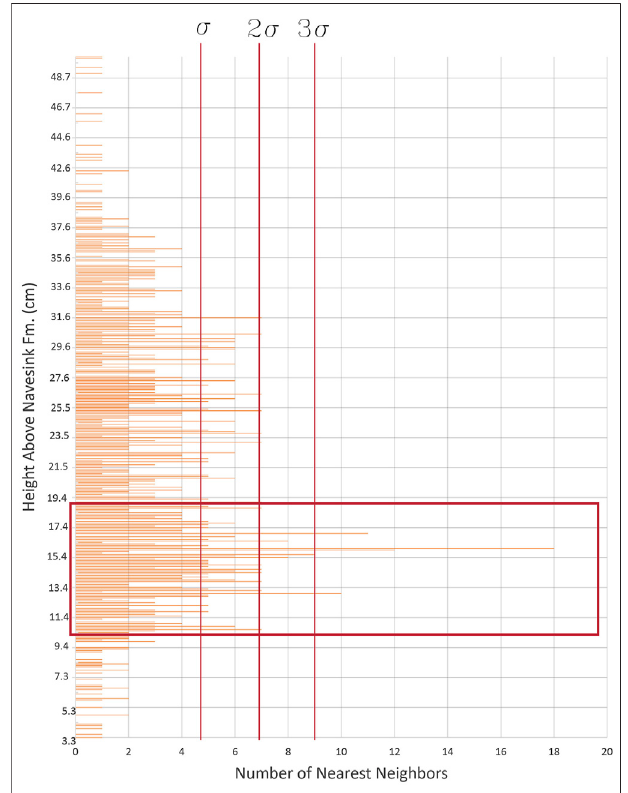
FIGURE 5 | A histogram of the general abundance of the oyster Pycnodonte dissimilaris by 1 mm stratigraphic bins, presented as the number ofoystersineachbin whichwerefoundtobethenearestneighborforanother oyster. Only one interval, from 10.6 to 19.1 cm above the NHC, exhibits frequency values consistently greater than two standard deviations above the